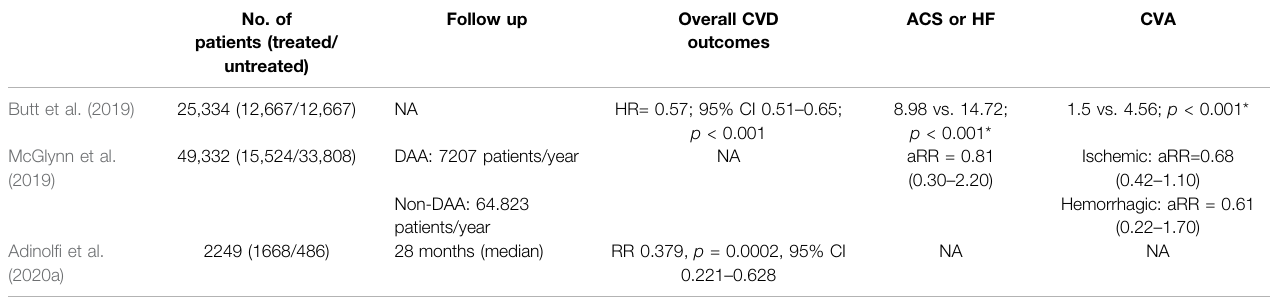
TABLE 1 | Overview of the recent studies assessing the reduction in cardiovascular risk following DAA treatment. No. of patients